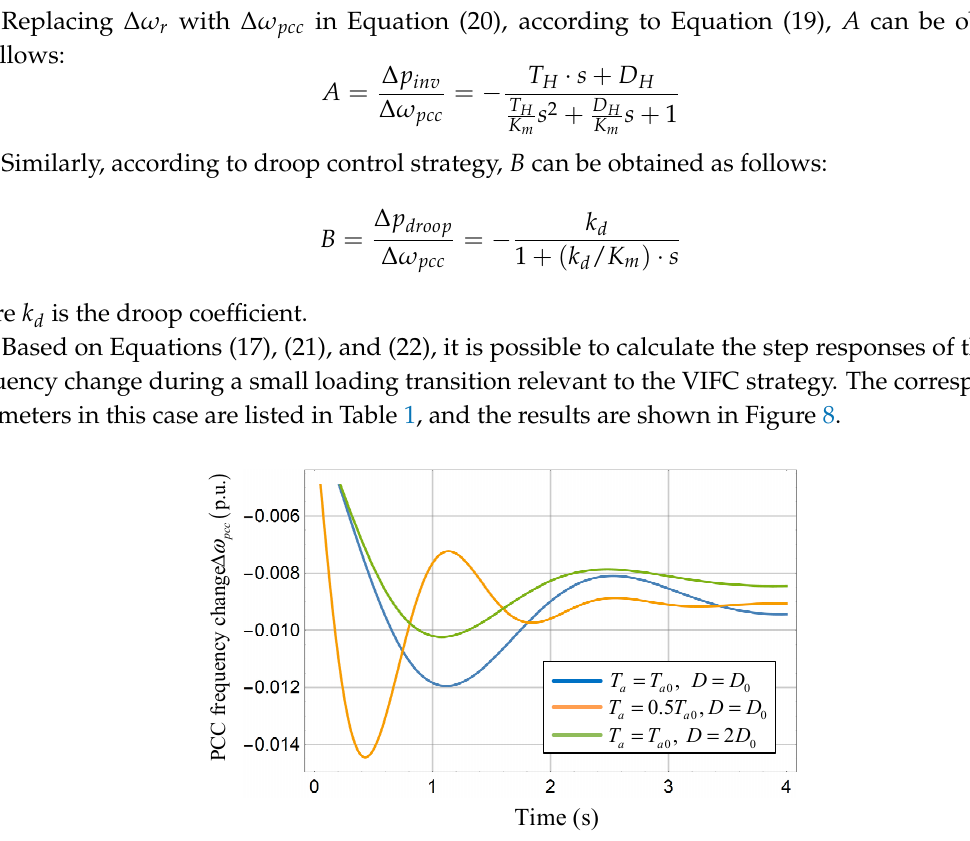
Figure 8. Step response of point of common coupling (PCC) frequency during a loading transition in parallel operation mode with various parameters.